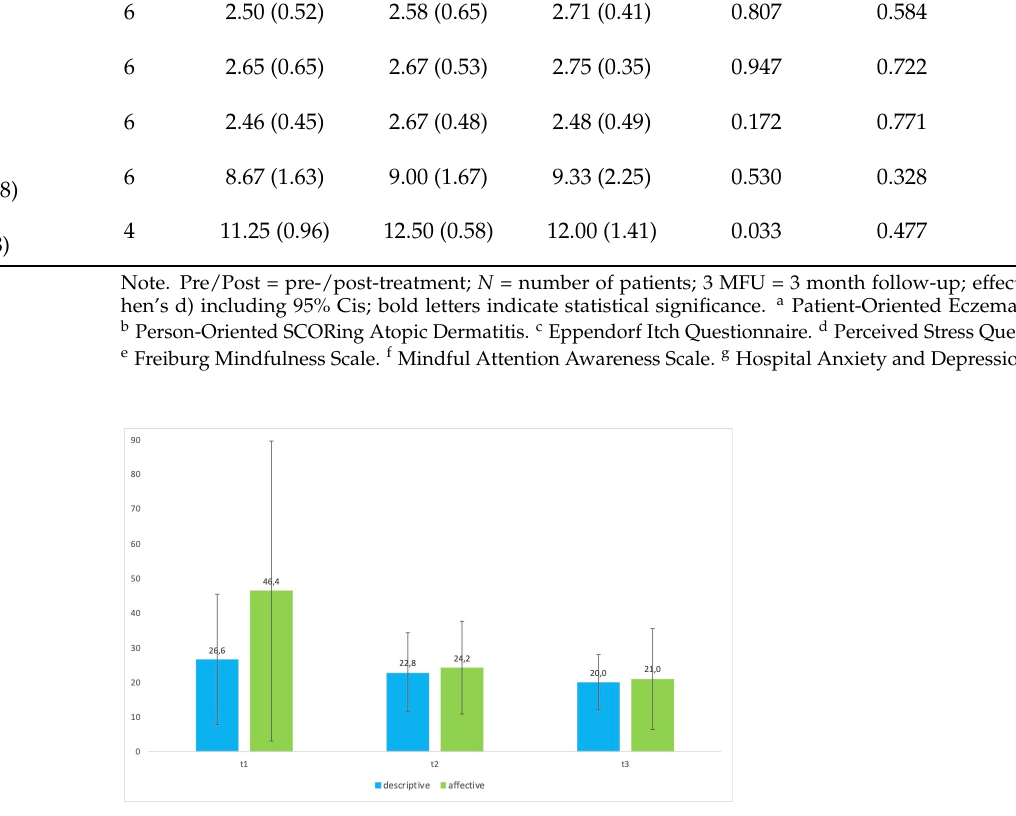
Figure 1. Differences in descriptive and affective itch experiences at baseline, post-treatment and follow-up (mean sum scores and standard